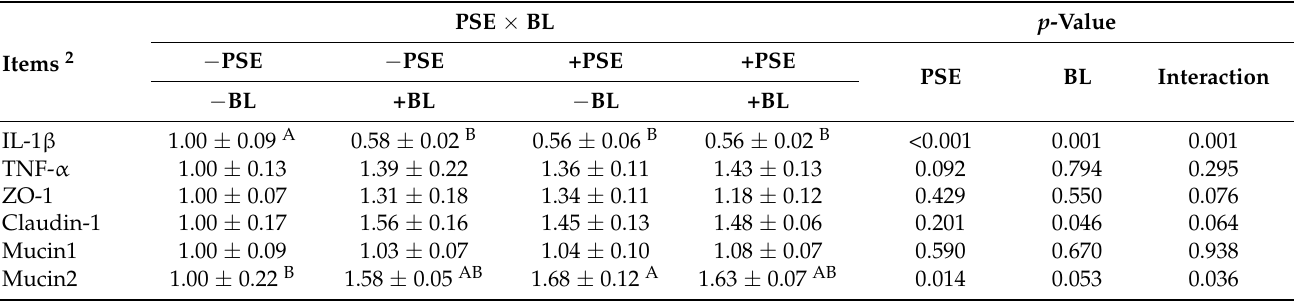
Table 6. Effects of BL and PSE on intestinal inflammatory factors and barrier gene expression in weaned piglets 1